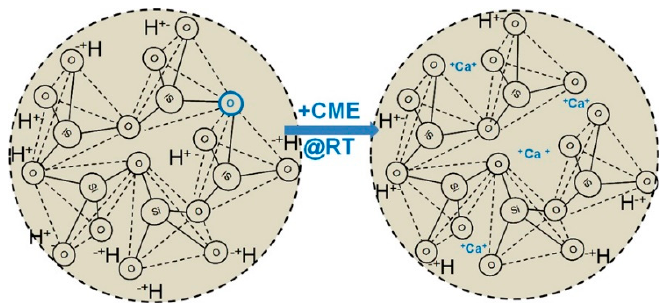
Figure 5. Schematic illustration of calcium incorporated in the glass network at room temperature using calcium methoxyethoxide (CME) as a calcium source in the sol-gel synthesis [209]. Reproduced with permission from the cited reference.